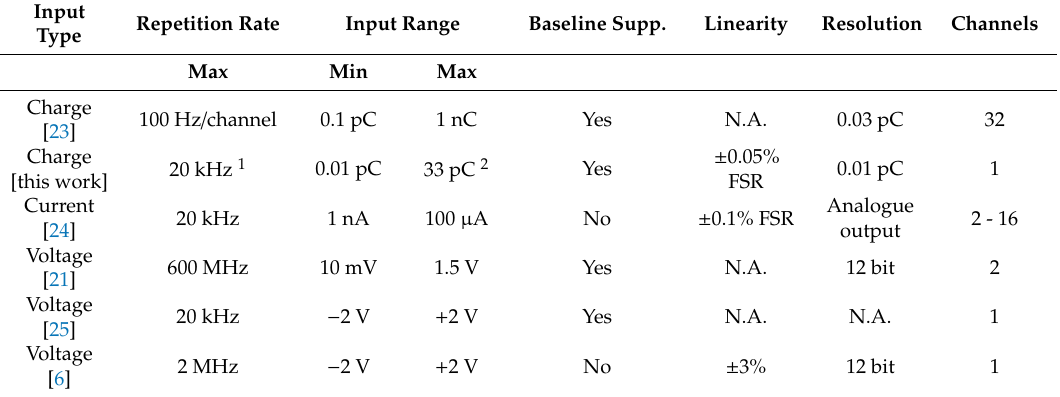
Table 3. Comparison of performances of gated integrator systems found in scientific literature and commercial webpages (see references reported in the first